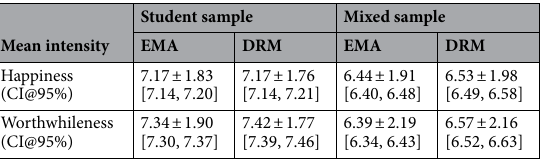
Table 1. Descriptive statistics of SWB intensity scores for each sample, method, and measure, with confidence interval at 95%